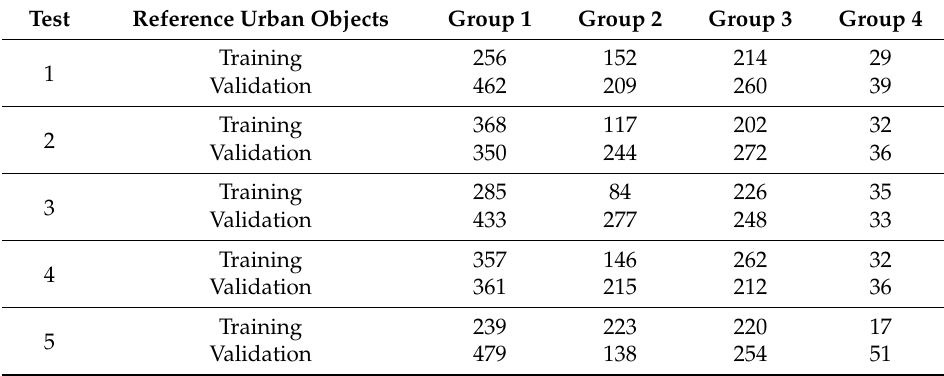
Table 1. The numbers of reference urban objects for training and validation from different city groups in five